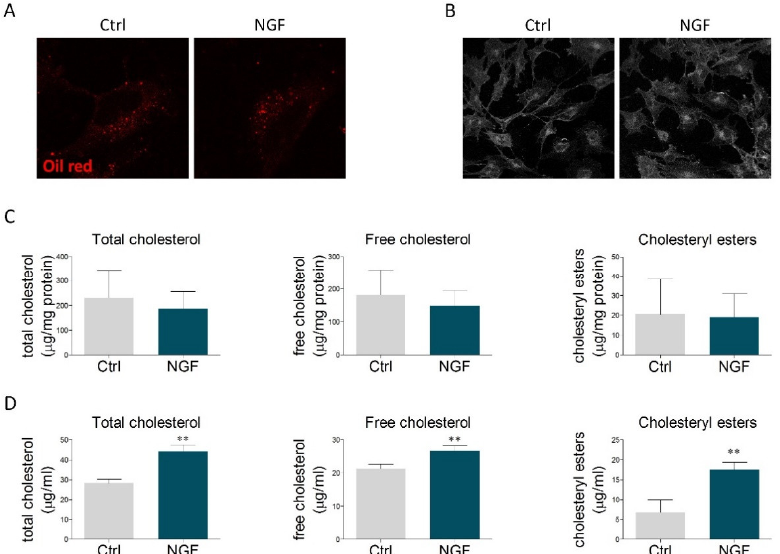
Figure 2. NGF effects on neutral lipids and cholesterol content. ( A ) U373 cells were treated with vehicle (Ctrl) or NGF (100 ng/mL) for 48 h and then stained with Oil Red O to visualize the intracellular content of neutral lipids. n = 3 different experiments. ( B ) Representative image of filipin staining performed on U373 cells treated with vehicle (Ctrl) and NGF (100 ng/mL) for 48 h. n = 3 different experiments. ( C ) Quantification of intracellular cholesterol levels (total cholesterol, free cholesterol, and cholesteryl esters) in vehicle- and NGF-treated U373 cells. n = 3 different experiments. ( D ) Cholesterol quantification (total cholesterol, free cholesterol, and cholesteryl esters) in the culture medium of U373 cells treated with vehicle (Ctrl) and NGF (100 ng/mL) for 48 h. n = 3 different experiments. Data represent means ± SD. Statistical analysis was performed by using unpaired Student’s t -test. ** p <0.01.